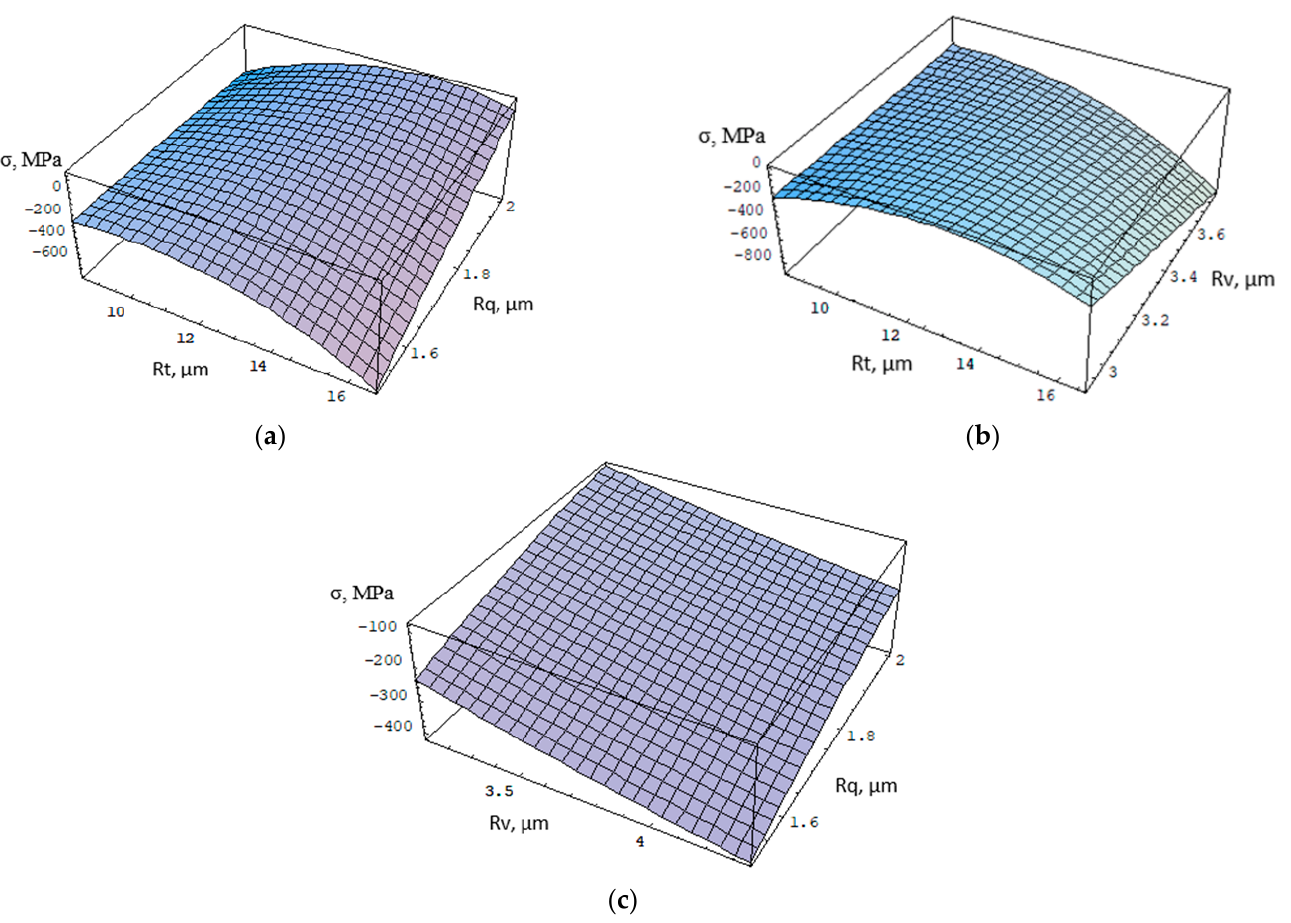
Figure 9. Approximation function for BM: ( a ) Rv = 3.10 μ m, ( b ) for Rq = 1.74 μ m, ( c ) Rt = 10 μ m.